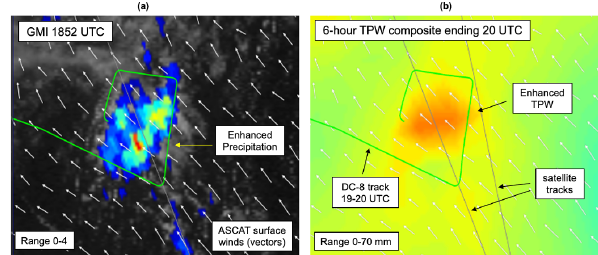
Figure 16. Depiction of the observed rain index (a) derived from GMI at 18:52UTC, shown in the JPL CPEX data portal overlaid on top of the ASCAT-derived ocean surface winds at 19:00UTC. (b) The 6h composite of the observed total precipitable water (TPW), also available from the CPEX data portal (b) .